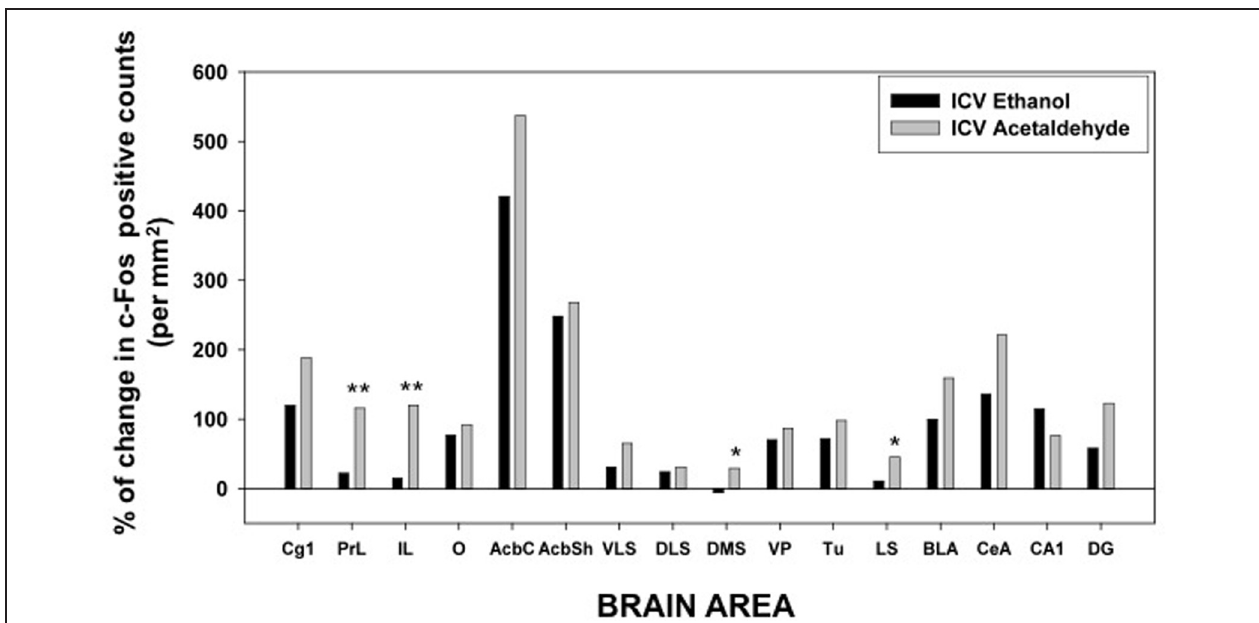
FIGURE 5 | Percentage of change in c-Fos counts after ICV administration of ethanol and acetaldehyde (2.8 µ moles) in relation to the aCSF vehicle group for every brain structure. ∗ p < 0 . 05, ∗∗ p < 0 . 01 different from EtOH in that brain